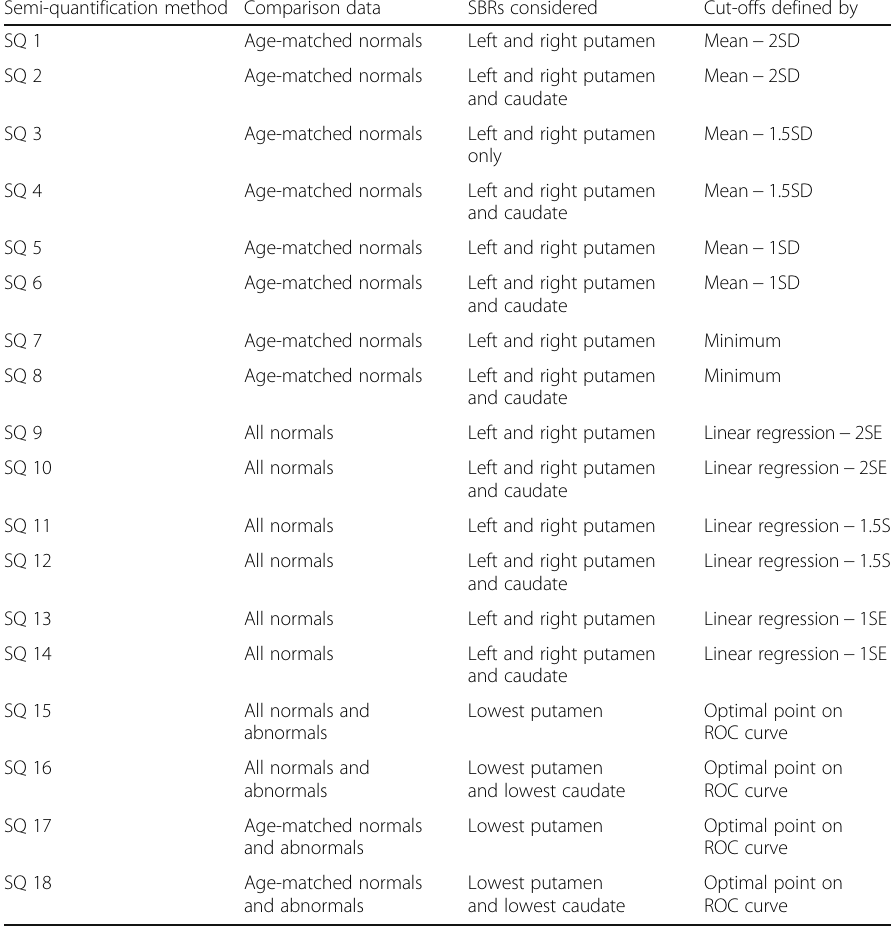
Table 3 Summary of the semi-quantitative methods investigated. Methods are principally grouped according to the particular technique for defining the SBR cut-off Semi-quantification method Comparison data